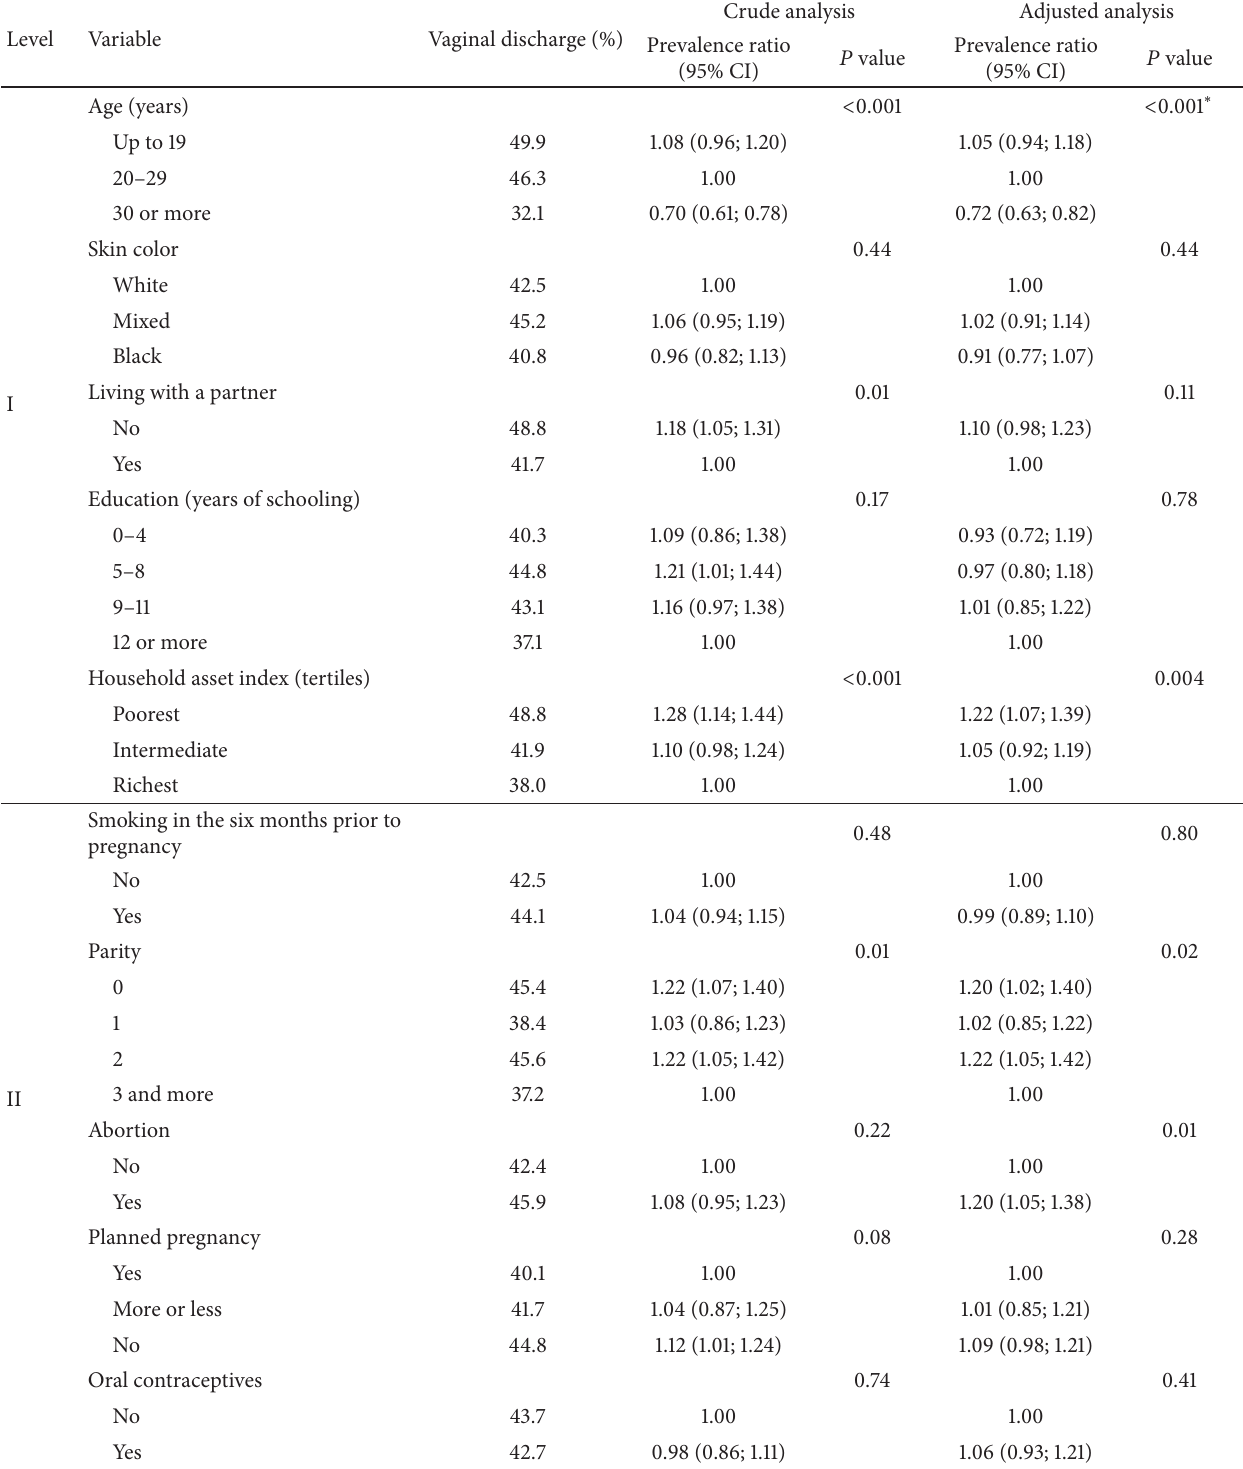
Table 2: Crude and adjusted analysis of factors associated with the prevalence of pathological vaginal discharge during pregnancy. Rio Grande, Brazil, 2010 ( 𝑁 = 2, 395